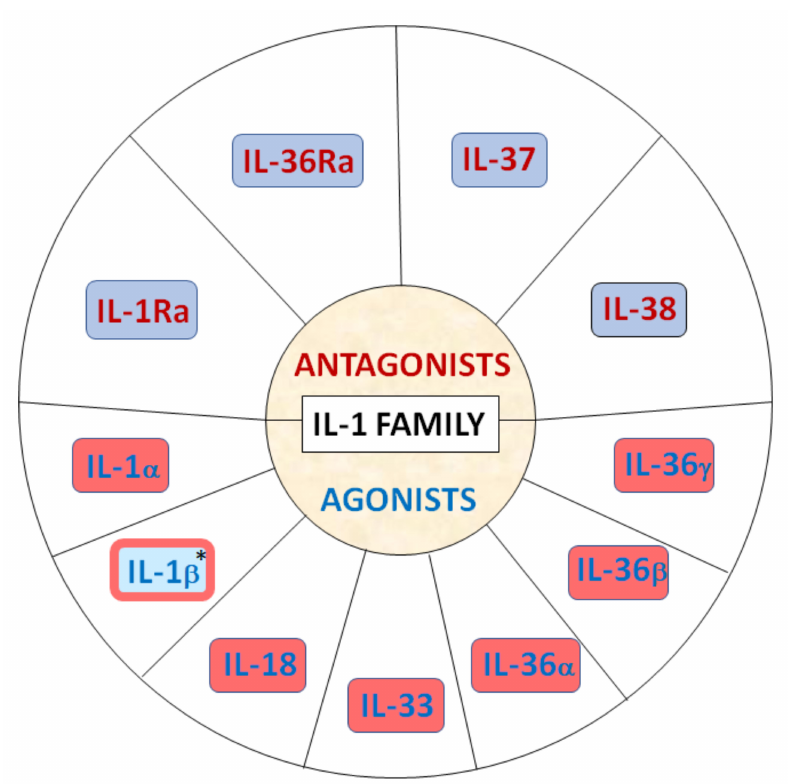
Figure 1. IL-1 family antagonists (highlighted in red font) and agonists (highlighted in blue font). Pro-inflammatory cytokines shown on red background and anti-inflammatory on blue background. * IL-1 β may function both inflammatory and anti-inflammatory, depending on the specific